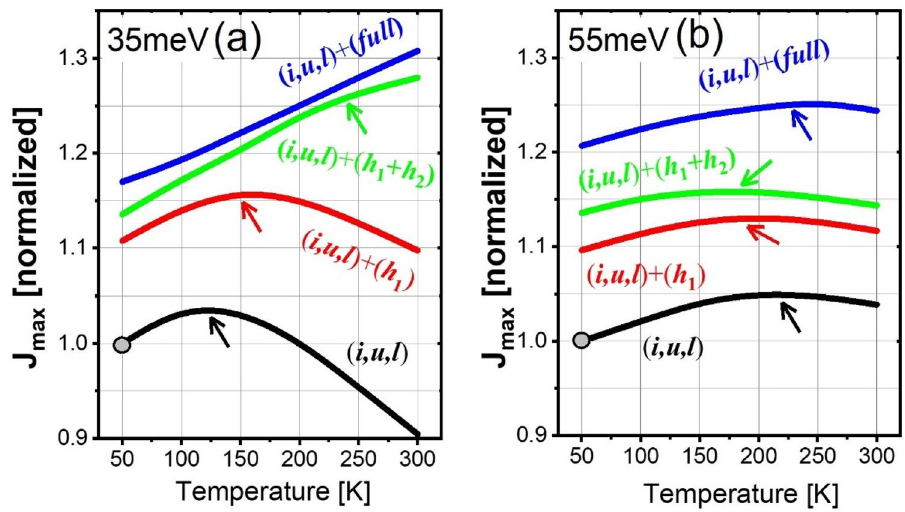
Figure 4. J max as functions of temperatures under different scale levels for both the 35 meV design ( a ) and 55 meV design ( b ). J max in the ( i , u , l )-scale at 50 K is normalized as 1 and used as a standard.